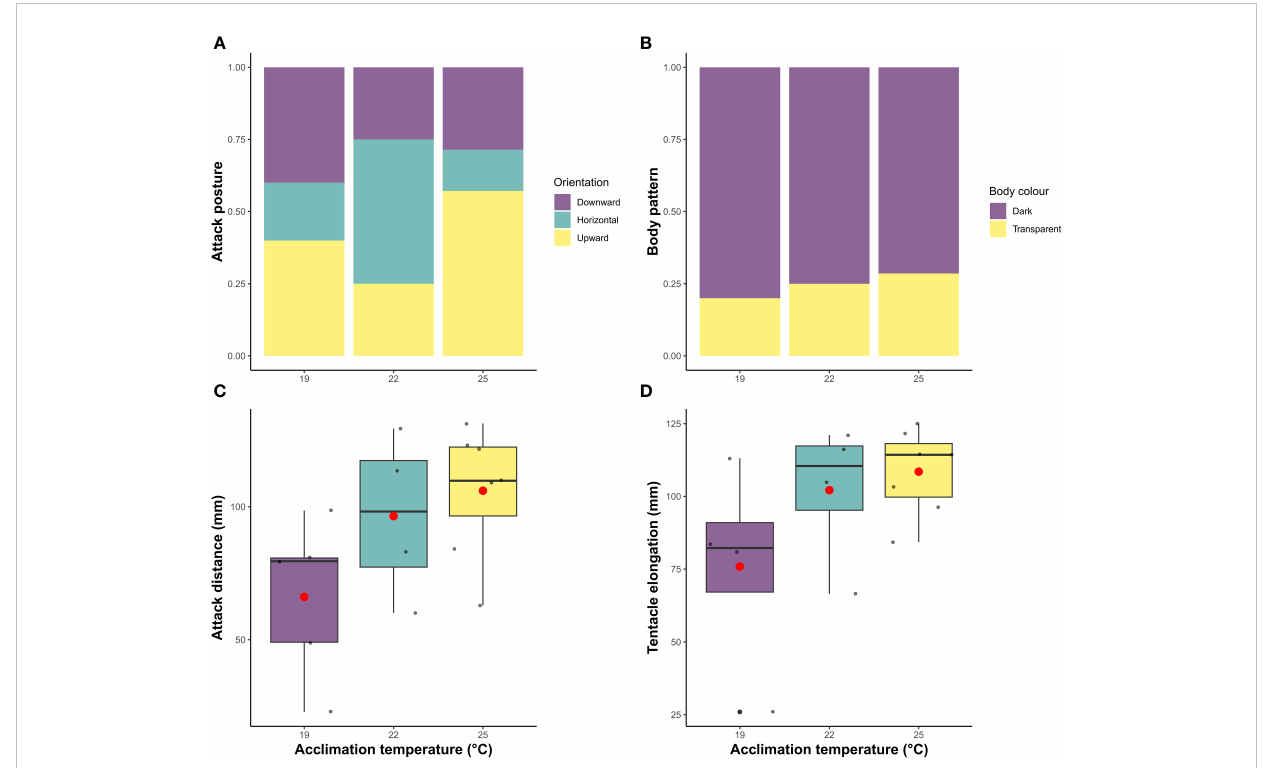
FIGURE 5 Behavioural measures of southern calamari ( Sepioteuthis australis ) that successfully attacked prey at different temperatures of acclimation (19, 22 and 25°C). (A) the proportion of squid exhibiting the different positions of attack (downward, horizontal arms, and upward). (B) the proportion of squid exhibiting different body display patterns (dark and transparent). (C) boxplots of the attack distance (mm) and (D) tentacle elongation (mm). In the boxplot, points indicate individual values and boxes represent the fi rst and third quartiles. Within each box, the median is represented by the solid line and the mean by the red